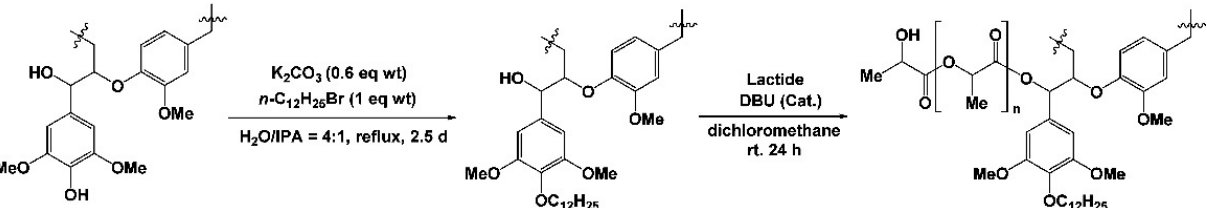
Figure 12. Synthesis route used for lignin and PLA biopolymers [97].